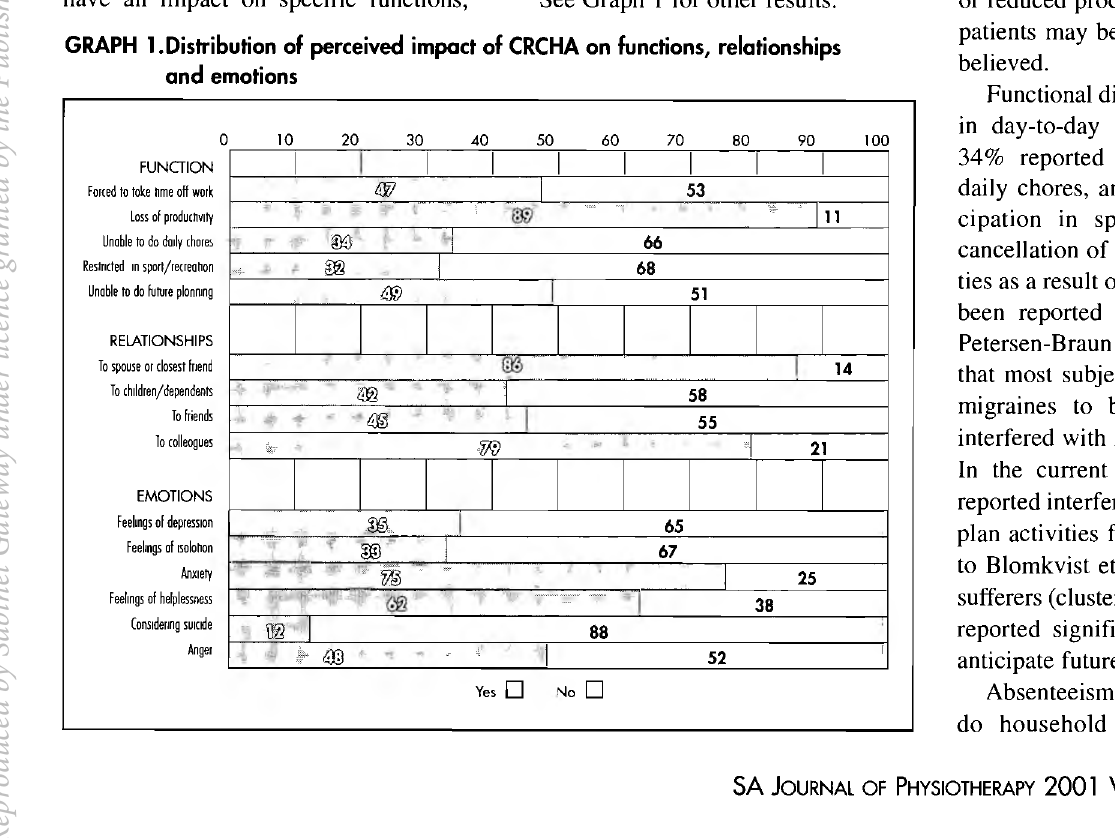
GRAPH 1.Distribution of perceived impact of CRCHA on functions, relationships and